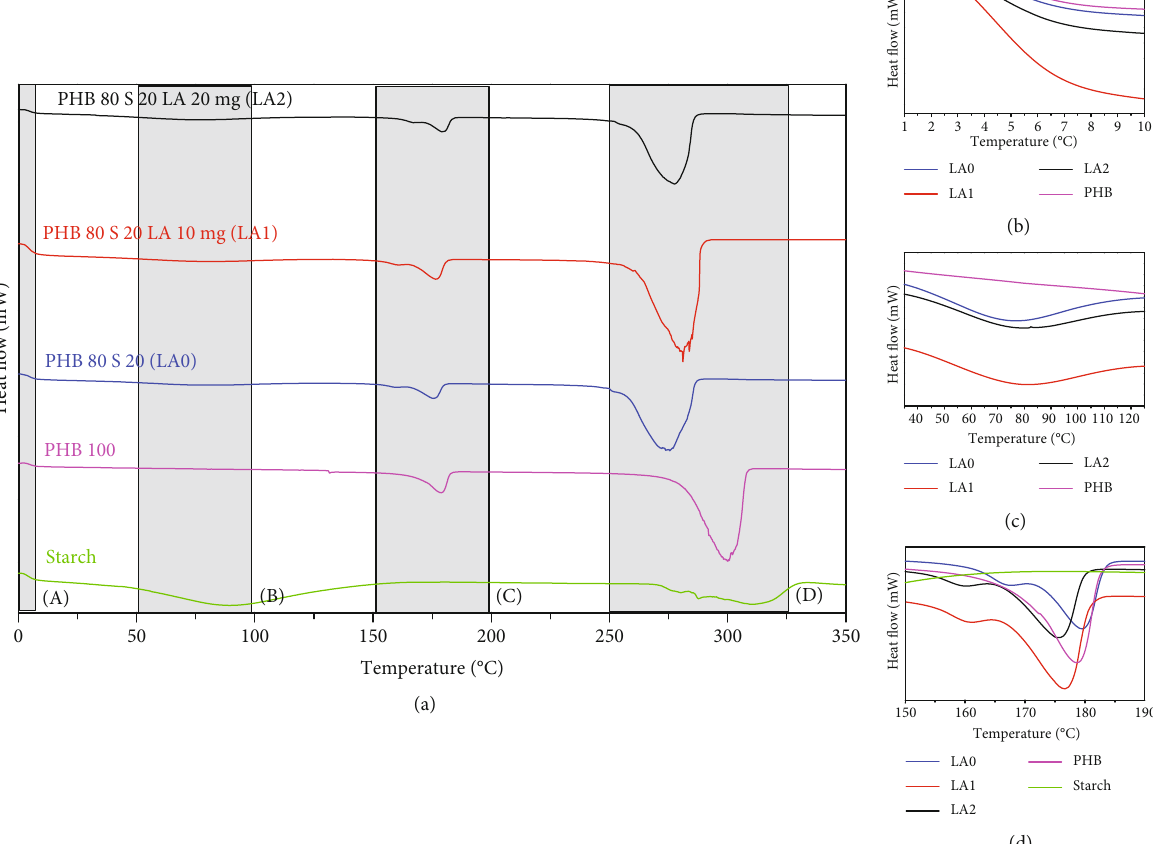
Figure 6: DSC curves of PHB, starch, and PHB/S/LA blends. (a) Full spectra. Endotherms are denoted by gray areas. (b – d) Enlarged Table 5: Thermal properties of PHB/S/LA composites.